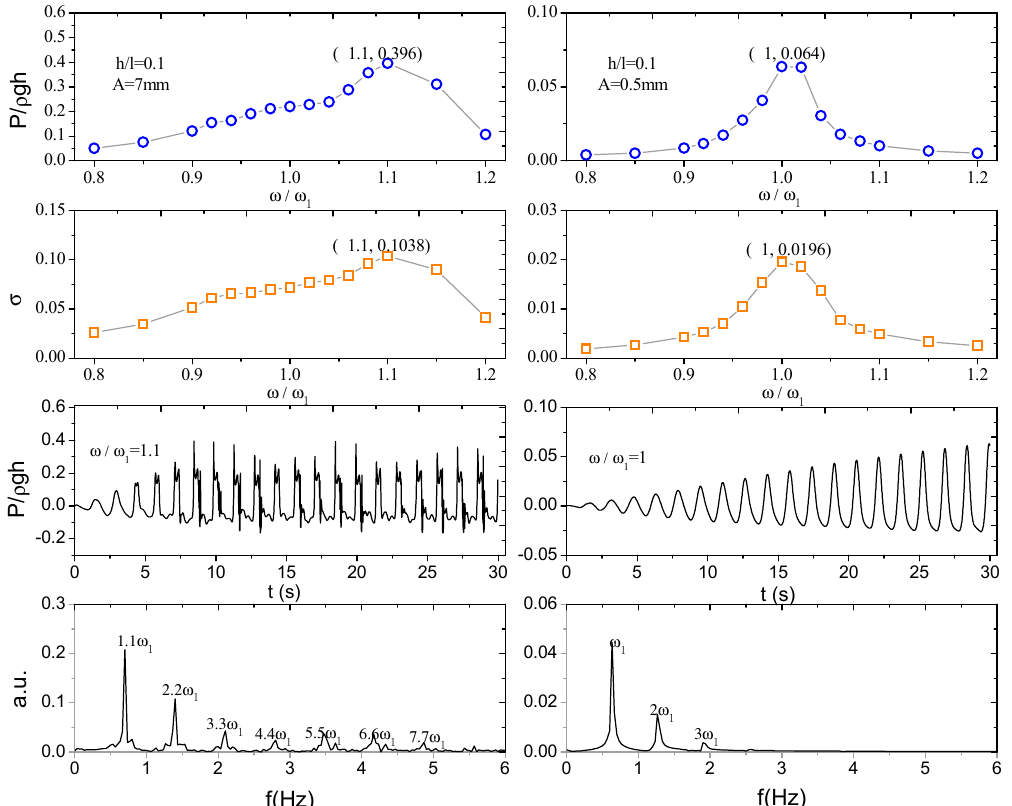
Figure 17. The effects of wave breaking on shallow water sloshing. ( left column : wave breaking; right column : no wave breaking).